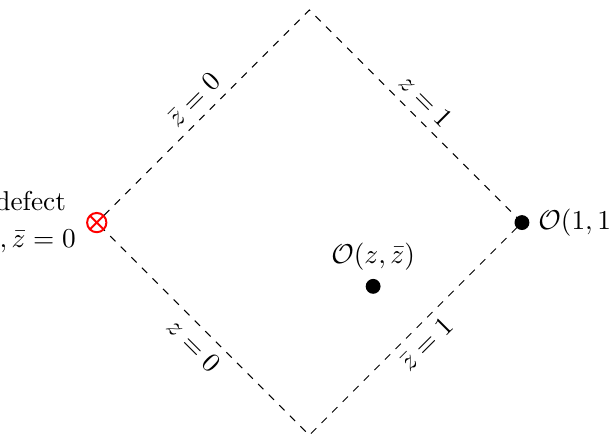
Figure 1. Setup for the two-point function of single-trace operators O 20 0 in the presence of a Wilson-line defect W in Euclidean 4 d space. Using scaling symmetry, the coordinate system can l be chosen such that x := (1 , 0 , 0 , 0) , while the second operator can be described with the help 1 of complex coordinates z, ¯ z as indicated in the text. The line extends out of the page (in the τ - direction) and is orthogonal to the complex